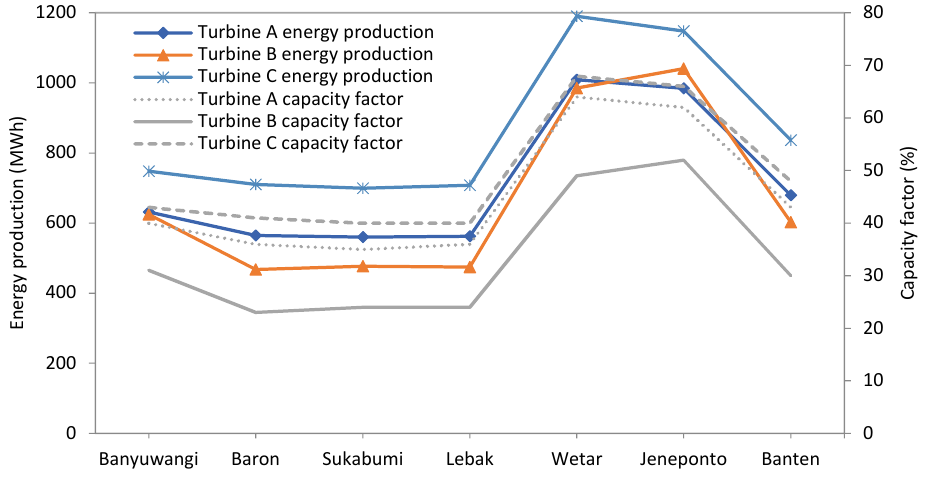
Figure 9. Power production and capacity factor of the turbines at all sites.